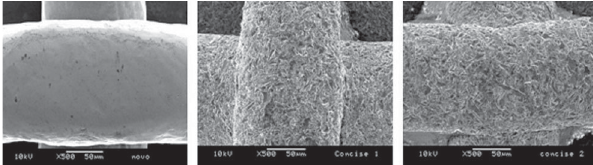
Fig. 2. Scanning electron micrographs of a bracket base (A) after first (B) and second recycling (C) with aluminum oxide blasting.